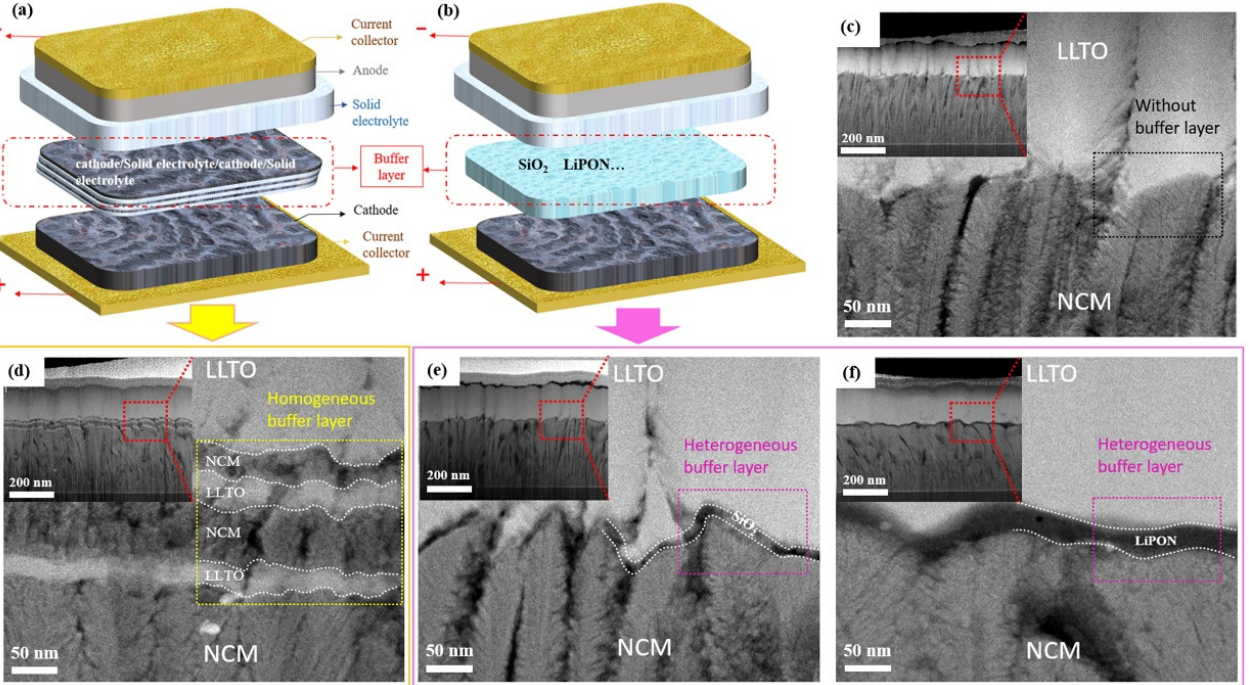
Figure 2. Schematic diagram of buffer layer: ( a ) Homogeneous buffer layer, ( b ) heterogeneous buffer layer. Cross ‐ sectional transmission electron microscopy (TEM) image of NCM/LLTO thin ‐ film interface, ( c ) NCM/LLTO, ( d ) NCM/(LLTO/NCM)/LLTO, ( e ) NCM/SiO 2 /LLTO, ( f ) NCM/LiPON/LLTO.